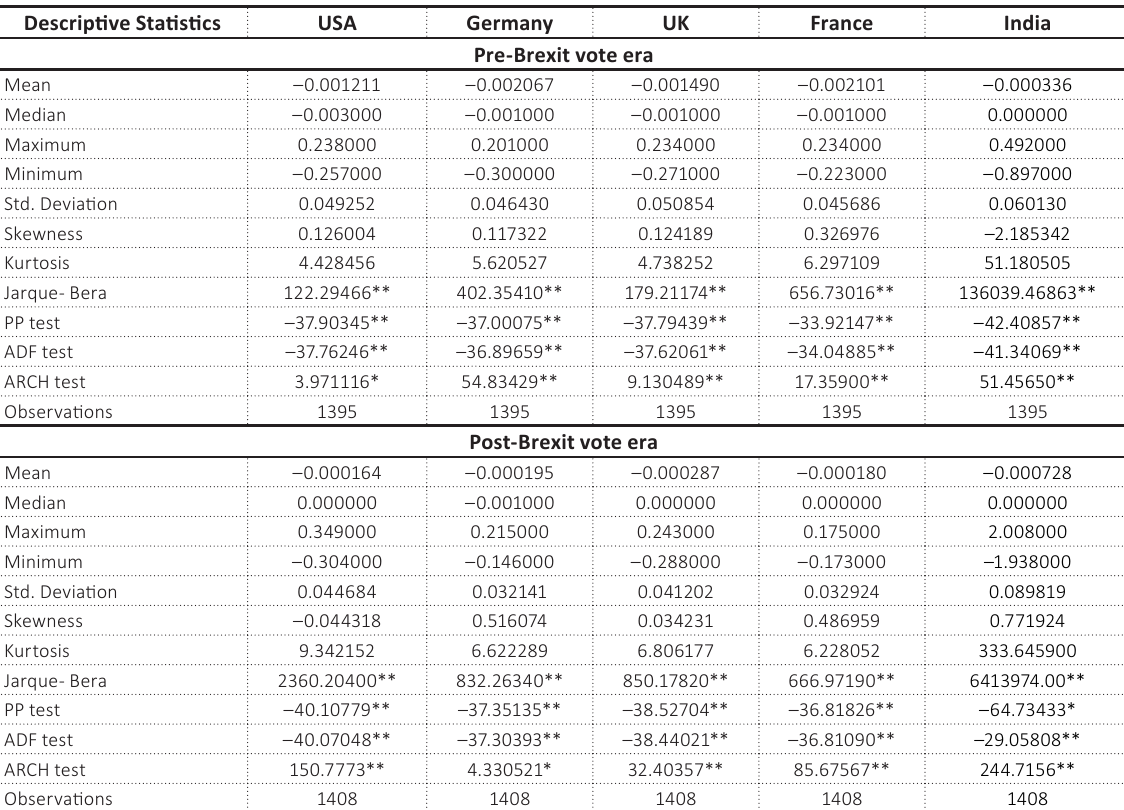
Figure 1. Pre-Brexit vote era bond Table 1. Descriptive statistics of 10-year government bond yields at first difference